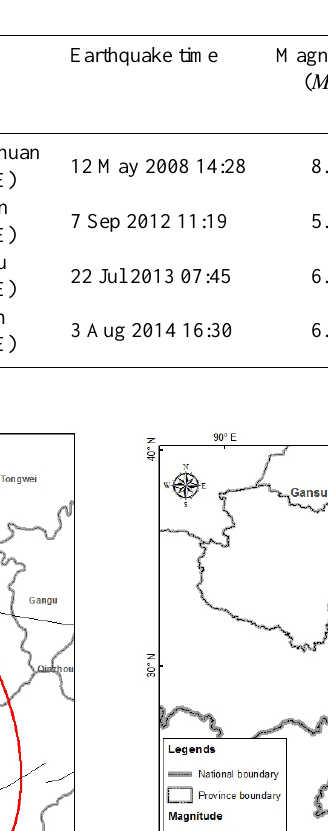
Table 4. Basic information on the test cases.